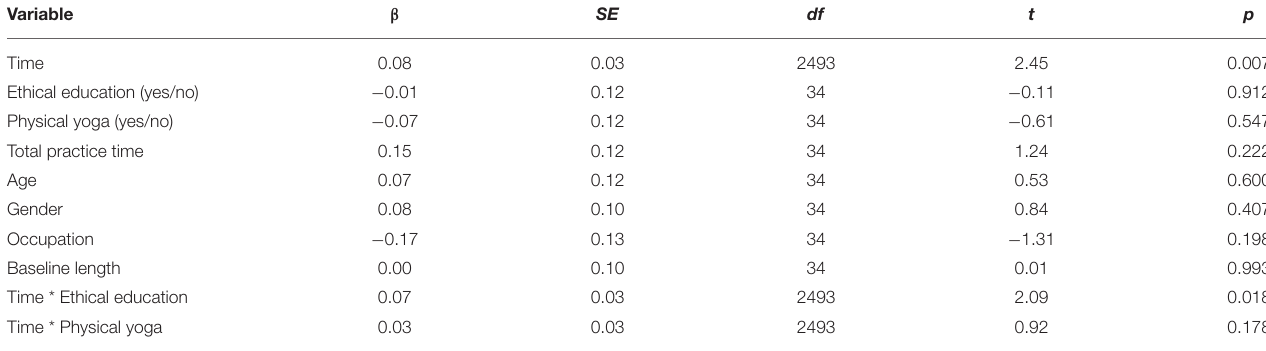
TABLE 5 | Multilevel regression estimates for well-being scores as dependent variable and time, effective component, age, gender, and baseline length as predictors.